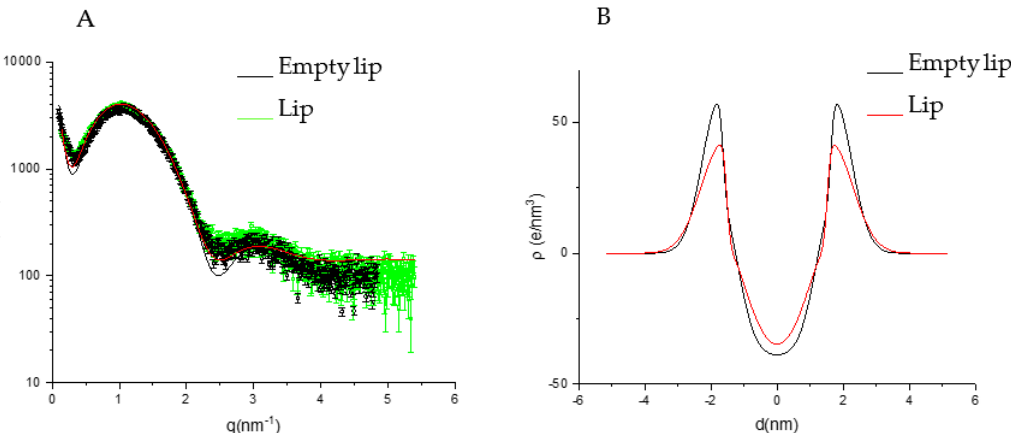
Figure 2. Cryo-TEM images of P. spinosa PG-PEVs. Two magnifications are shown: 15,000 × ( A ) and 20,000 × ( B ).